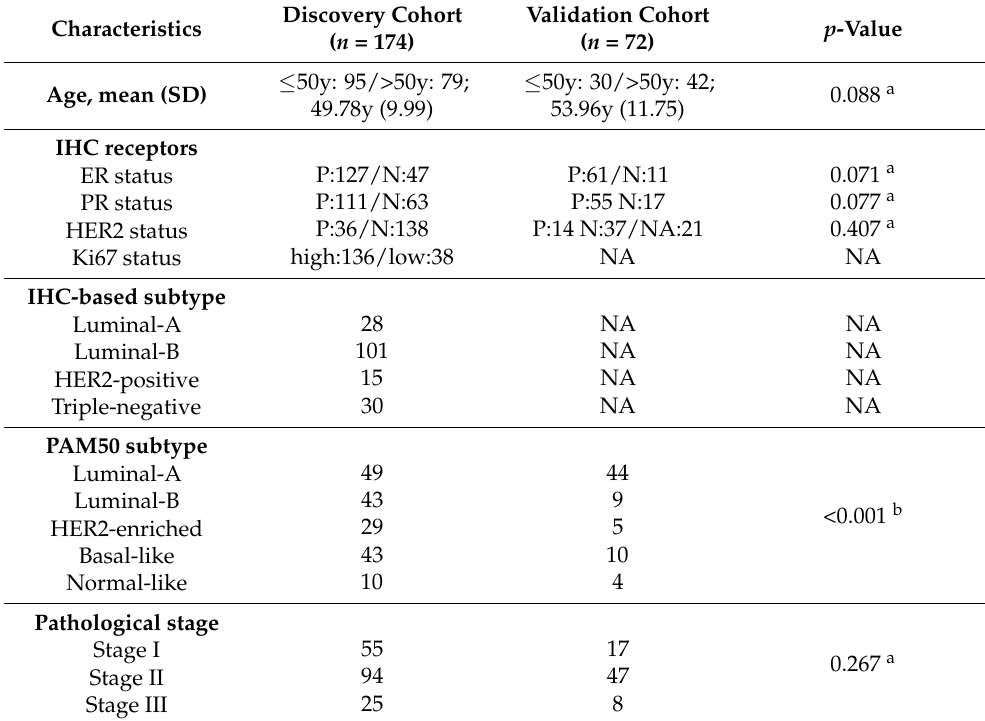
Table 1. The clinical and molecular characteristics of BC tumors in the radiogenomic discovery and validation cohorts.